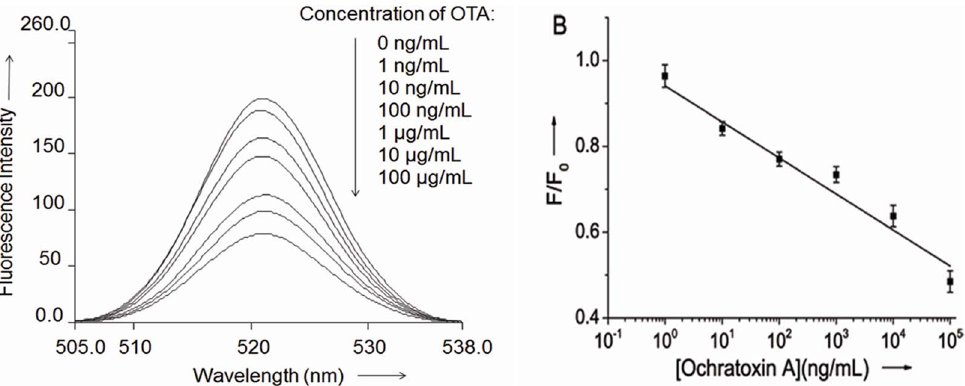
Figure 3. Label-free aptasensor using PG for detection of OTA. (A) Fluorescence spectra of the PG/aptamer duplex mixture in the presence of various concentrations of OTA. (B) Calibration plot relative F/F 0 of the PG/aptamer duplex mixture against different concentrations of OTA. F 0 and F stand for the fluorescent intensity in the absence and presence of OTA.